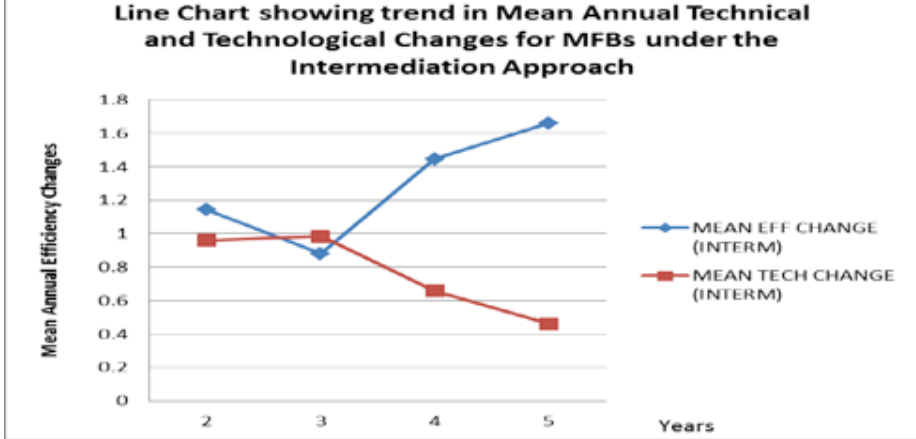
Figure 1. Trend in Mean Annual Technological (TECH) and Technical Changes (EFF) for MFBs (2006-